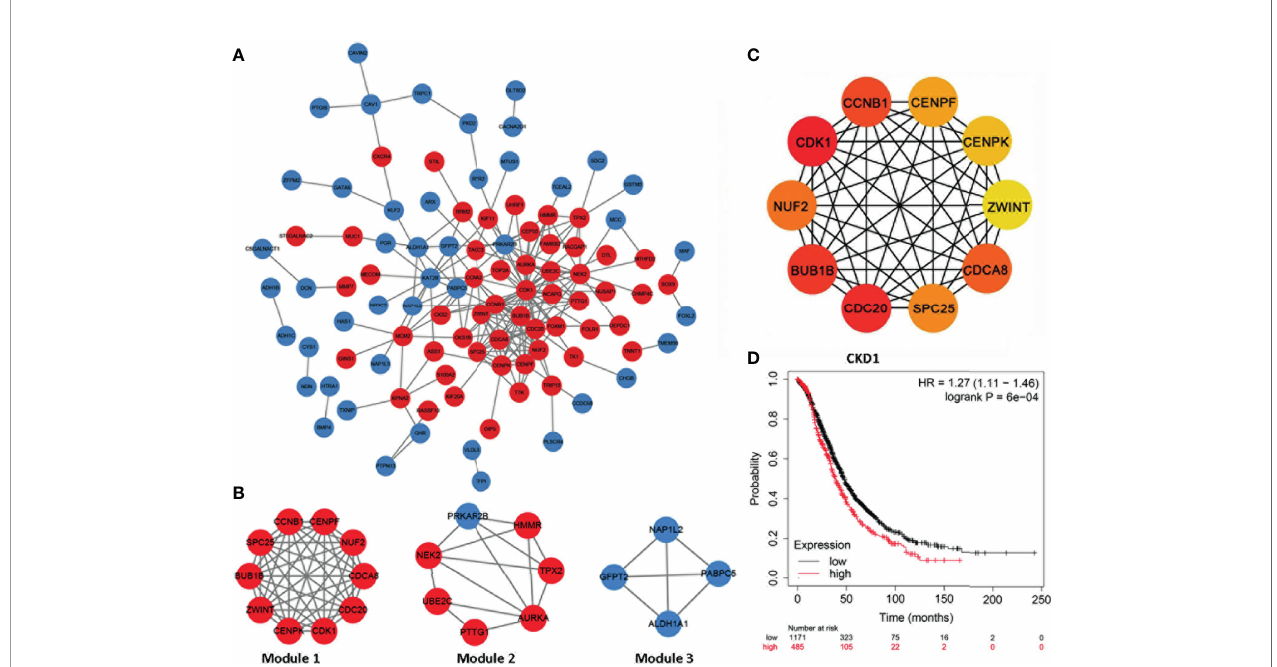
FIGURE 3 | The protein – protein interaction network and hub genes. (A, B) EOC-related network; red indicates common upregulated genes and blue represents and common downregulated genes. The internal interactions between common DEGs were mined by the Metascape database, and the network was visualized using Cytoscape software. (C) Top 10 EOC-related hub genes. The network was analyzed by the cytoHubba plugin of Cytoscape software with the method of MCC. All the hub genes were upregulated in EOC tissues. (D) High CDK1 expression was correlated with poor prognosis of ovarian cancer patients (hazard ratio =